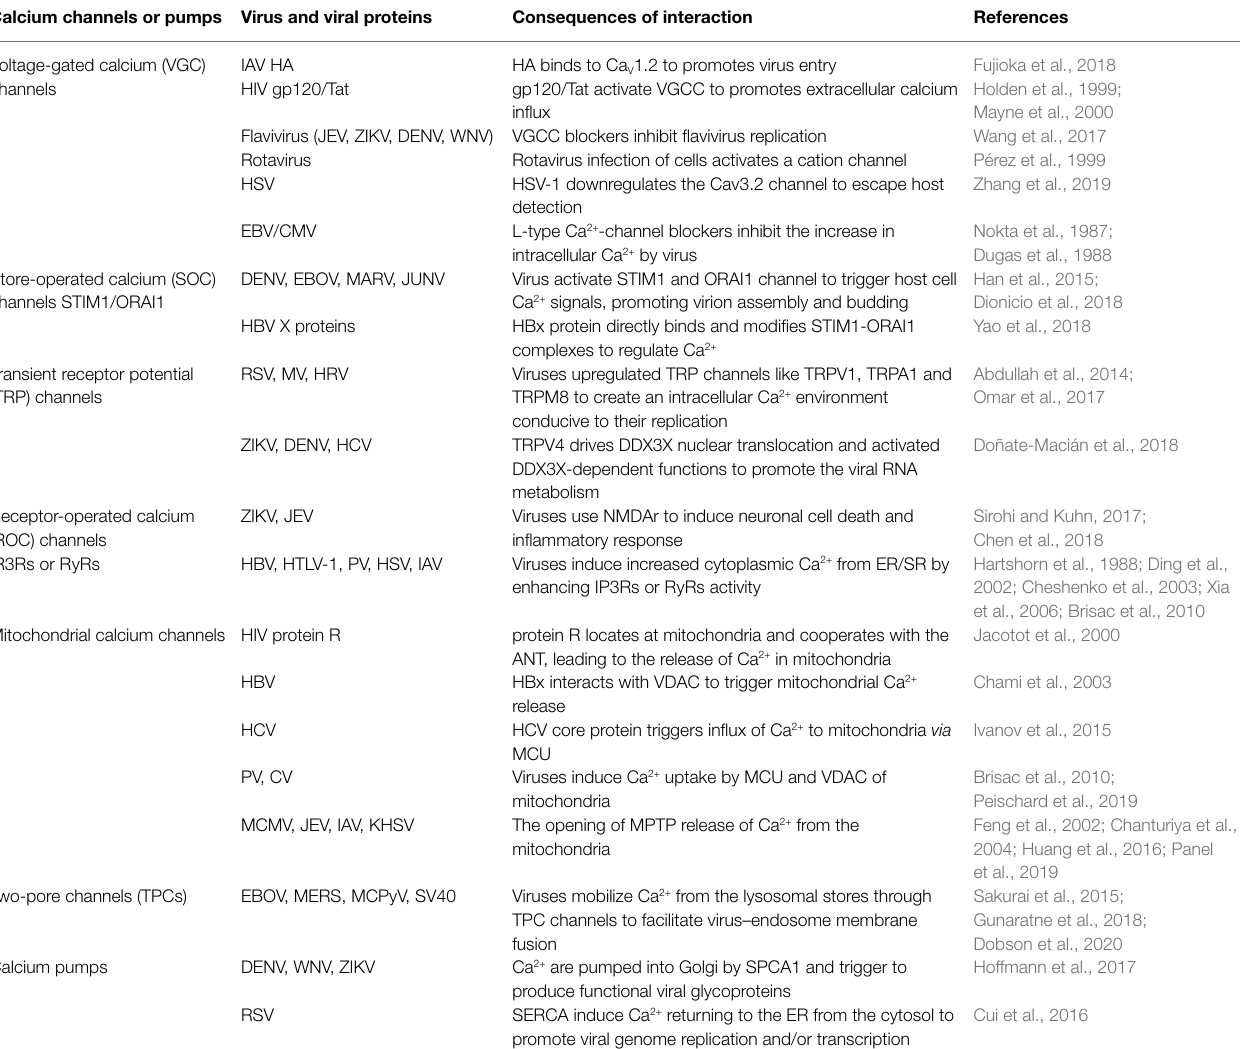
TABLE 1 | Ca 2+ channels and pumps used as targets by viruses. Calcium channels or pumps Virus and viral